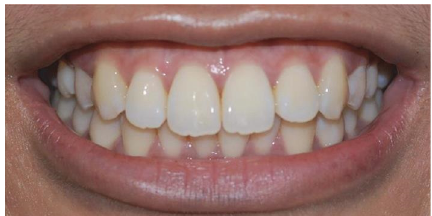
F IGURE 1: Photograph of smile characteristics close to standard norms.